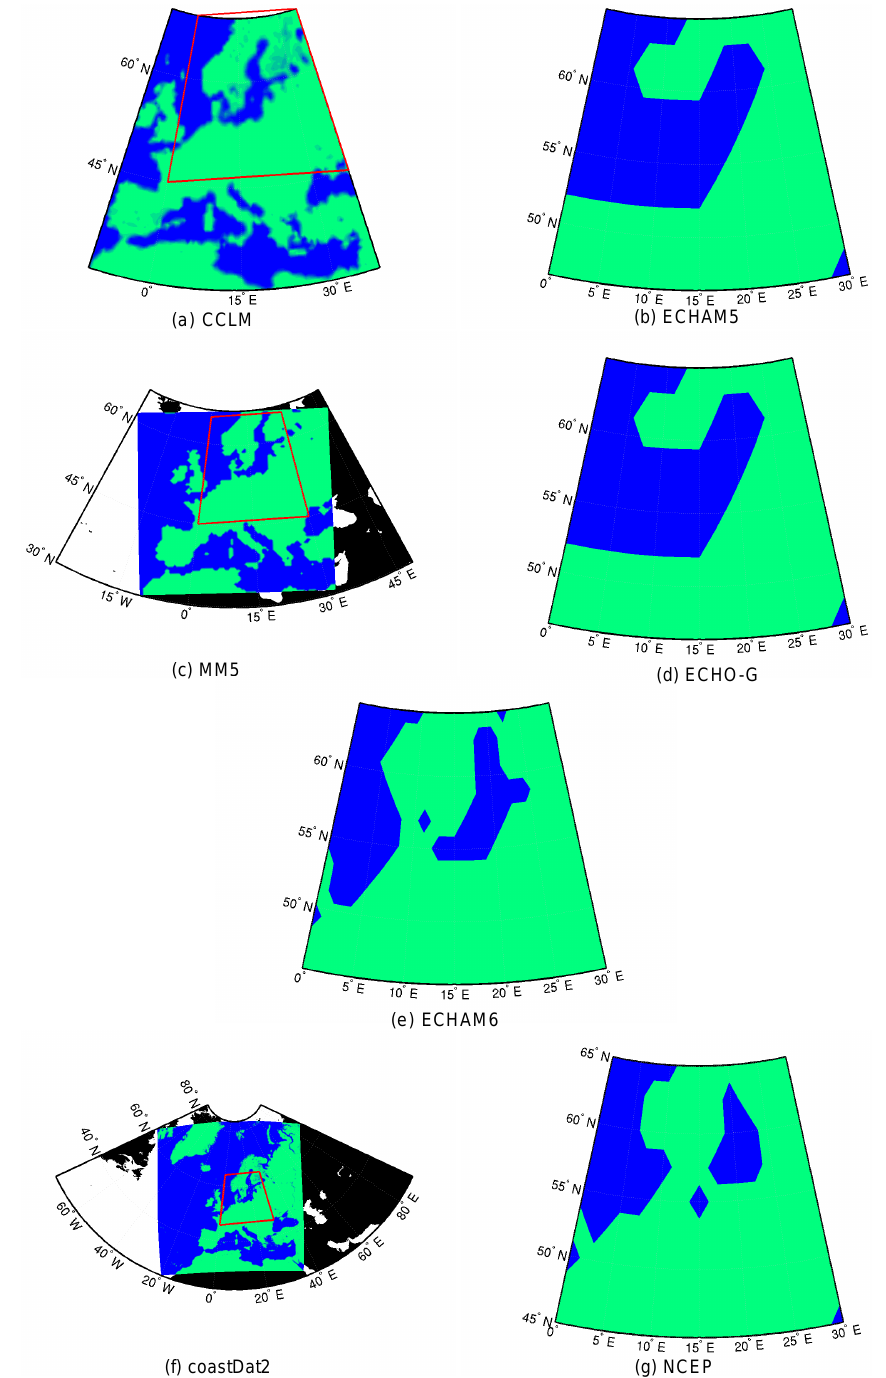
Figure 1. Land-Sea-Masks of the analysed simulations. Figures regarding global data sets (ECHAM5, ECHOG, ECHAM6, NCEP) only show the investigation area. Figures concerning regional data sets (CCLM, MM5, coastDat2) include the Land-Sea-Mask for the whole simulation domain and the investigation area is shown with a red